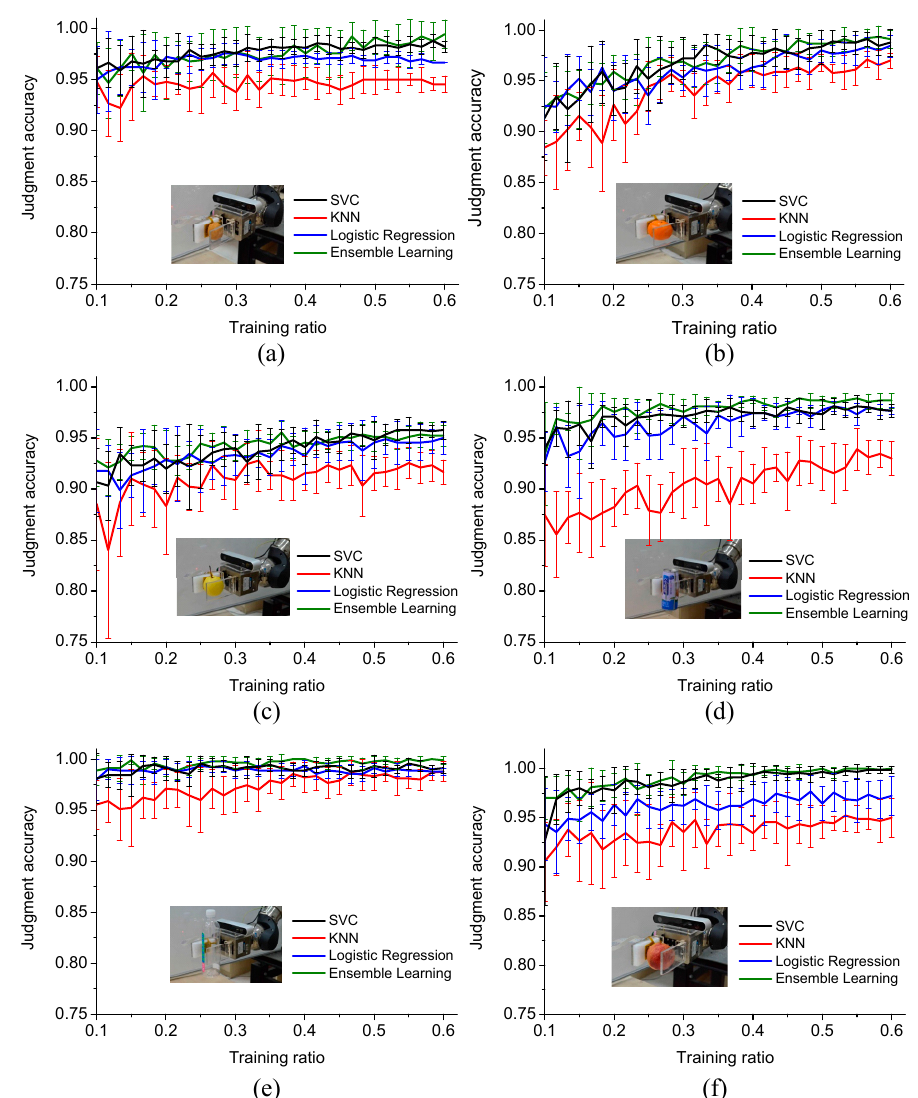
Figure 9. The influence of the different proportions of training data on the judgment accuracy of different objects: ( a ) egg, ( b ) orange, ( c ) pear, ( d ) pop-top can, ( e ) plastic bottle, ( f ) nectarine and the error bar represents standard deviation.